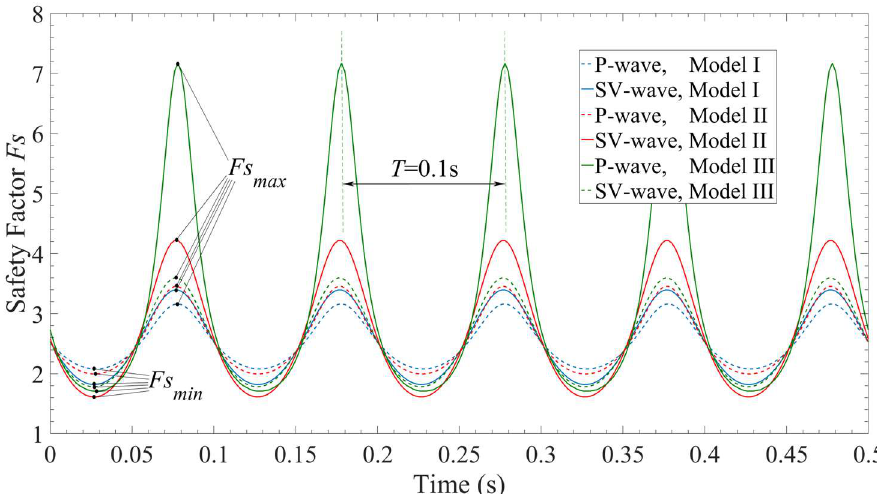
Figure 2. Instantaneous safety factor Fs (the dynamic parameters of model I are C P = 2500 m/s, C S = 1600 m/s, ρ = 2200 kg/m 3 ; C CP = 2500 m/s, C CS = 1600 m/s, ρ C = 2200 kg/m 3 , C BP = 3560 m/s, C BS = 2285 m/s, and ρ B = 2200 kg/m 3 are dynamic parameters for models II and III). (These values are roughly the mechanical parameters of hard sedimentary rocks in medium